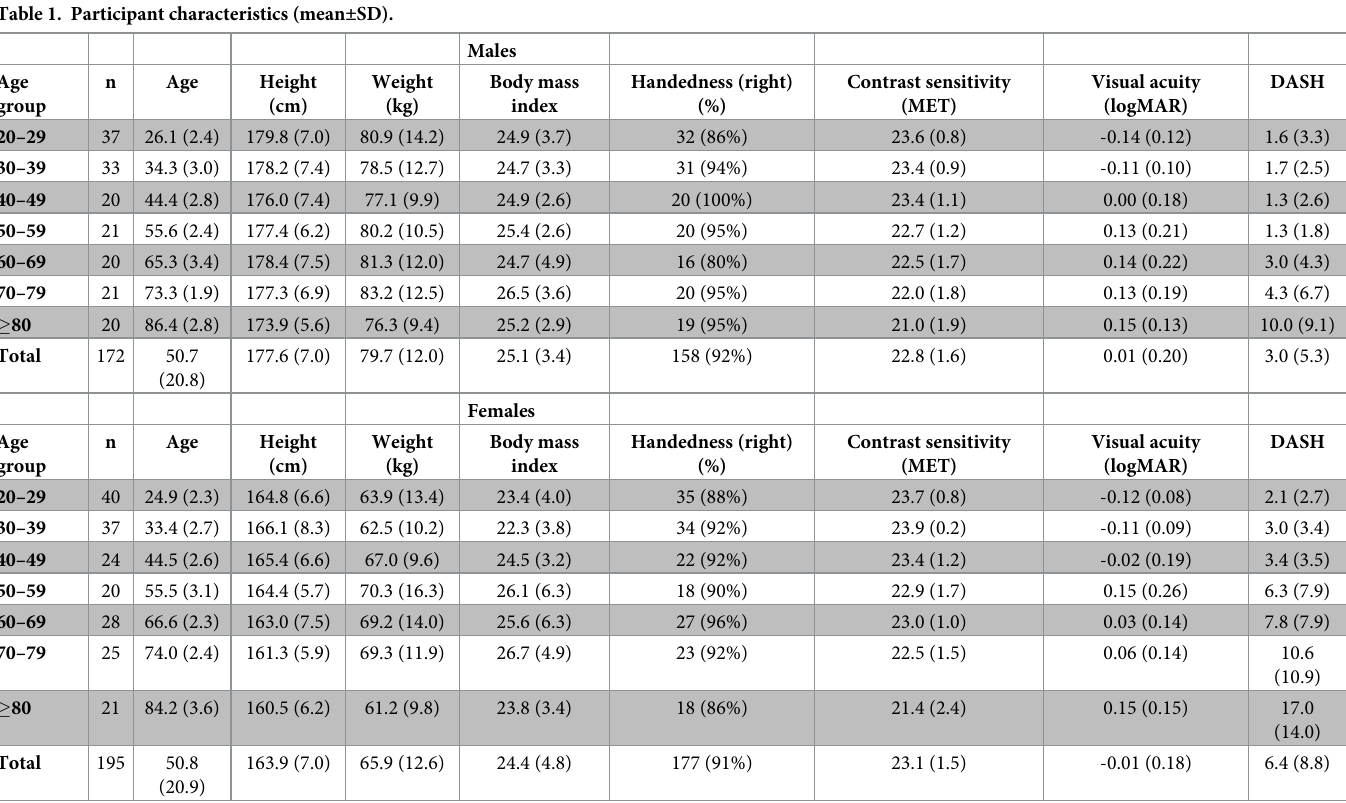
Table 1. Participant characteristics (mean ±